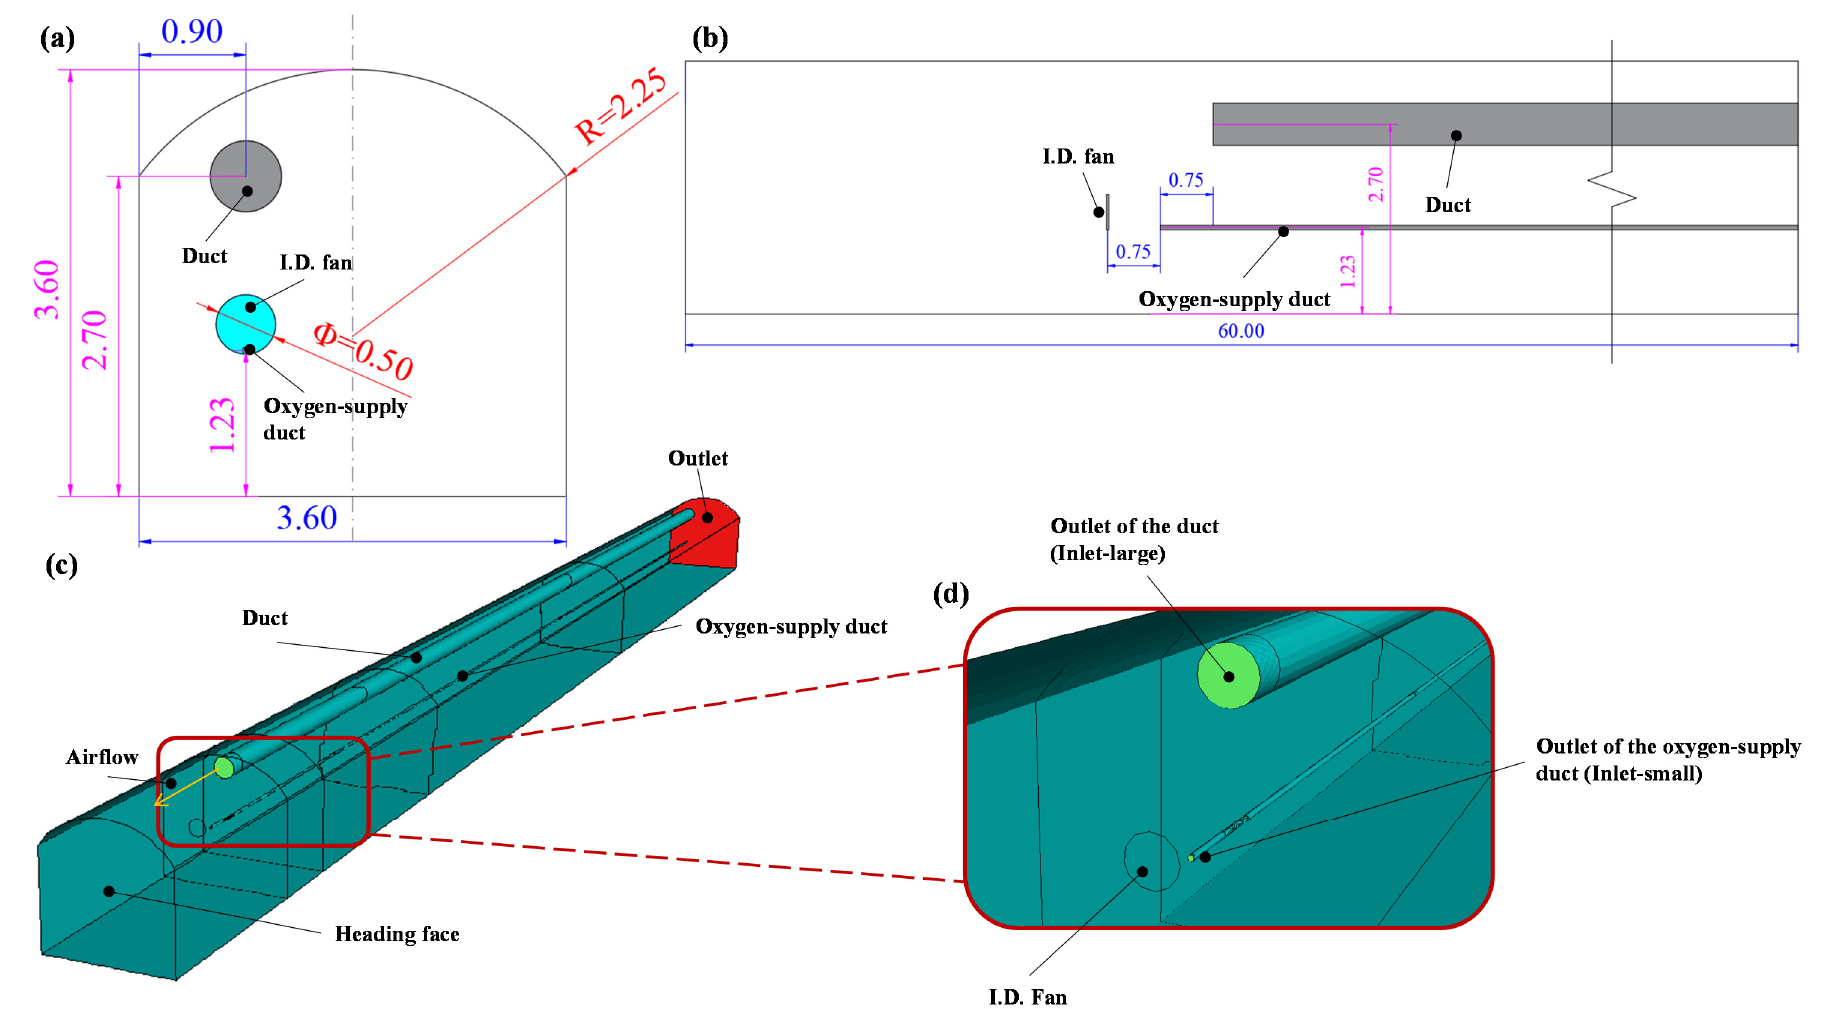
Figure 1. ( a ) Front-view of the simulation model; ( b ) side-view of the simulation model; ( c ) 3D simulation model of the single-heading tunnel; ( d ) localized enlargement of the 3D simulation model.